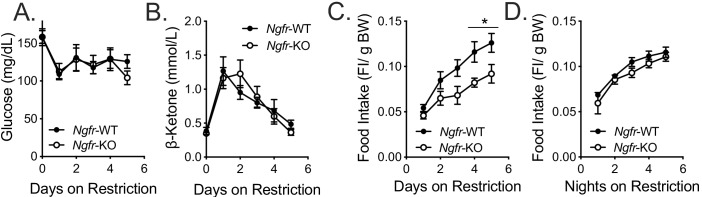
Glucose homeostasis and ketone production are intact in Ngfr-KO mice during daytime restricted feeding; Normalized food intake.Blood glucose (A) and β-hydroxybutyrate (B) levels measured at ZT0 during daytime restricted feeding; n = 6 WT, 8 KO. Not significant by two-way repeated measures ANOVA with Bonferroni multiple comparisons. (C) Daytime restricted food intake normalized to total starting body weight. *p=0.0347 (day 4), 0.0321 (day 5), F(1,10)=5.621 by two-way repeated measures ANOVA with Bonferroni multiple comparisons; n = 6/group. (D) Nighttime restricted food intake normalized to total starting body weight. Not significant by two-way repeated measures ANOVA with Bonferroni multiple comparisons. All mice are age and weight-matched. Data are presented as mean ± SEM.